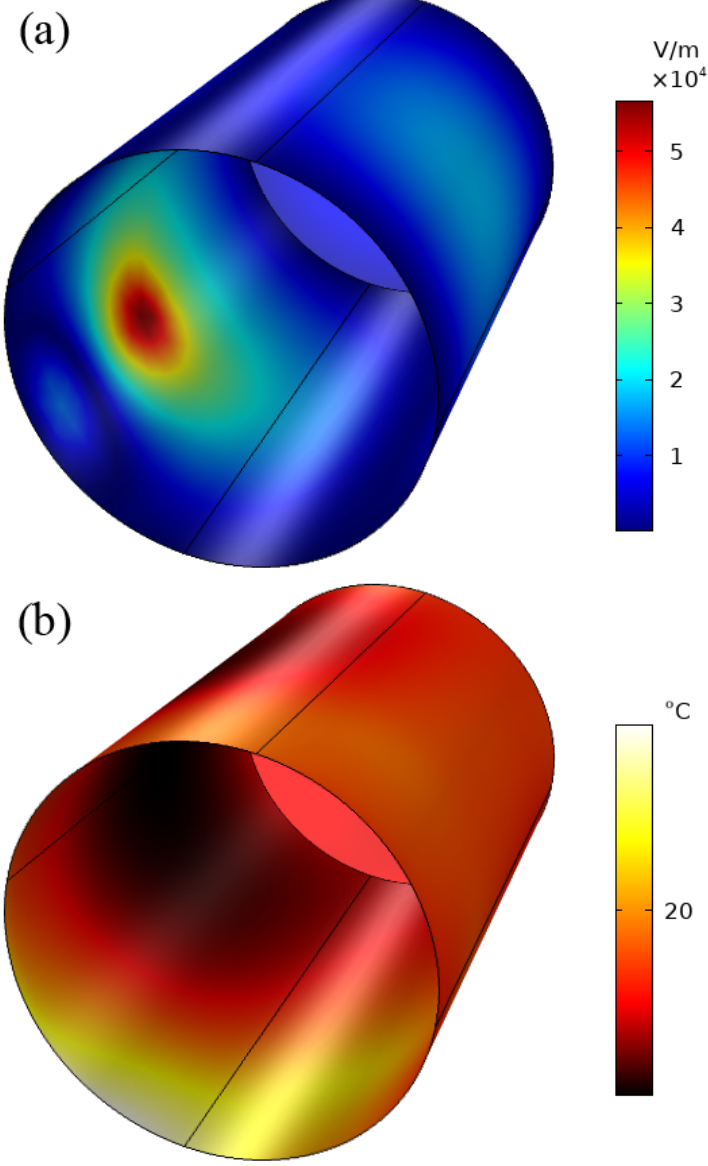
Figure 3. Electromagnetic–thermal distribution on the FTU internal surface: ( a ) electric field distribu- tion on the FTU internal surface; ( b ) thermal distribution on the